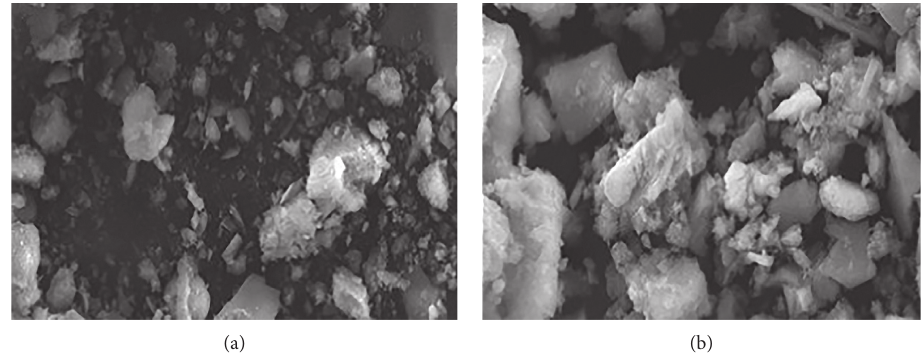
Figure 9: Microstructure of cement mantle at 5,000-time magnification. (a) Conventional blocks. (b) Improvised